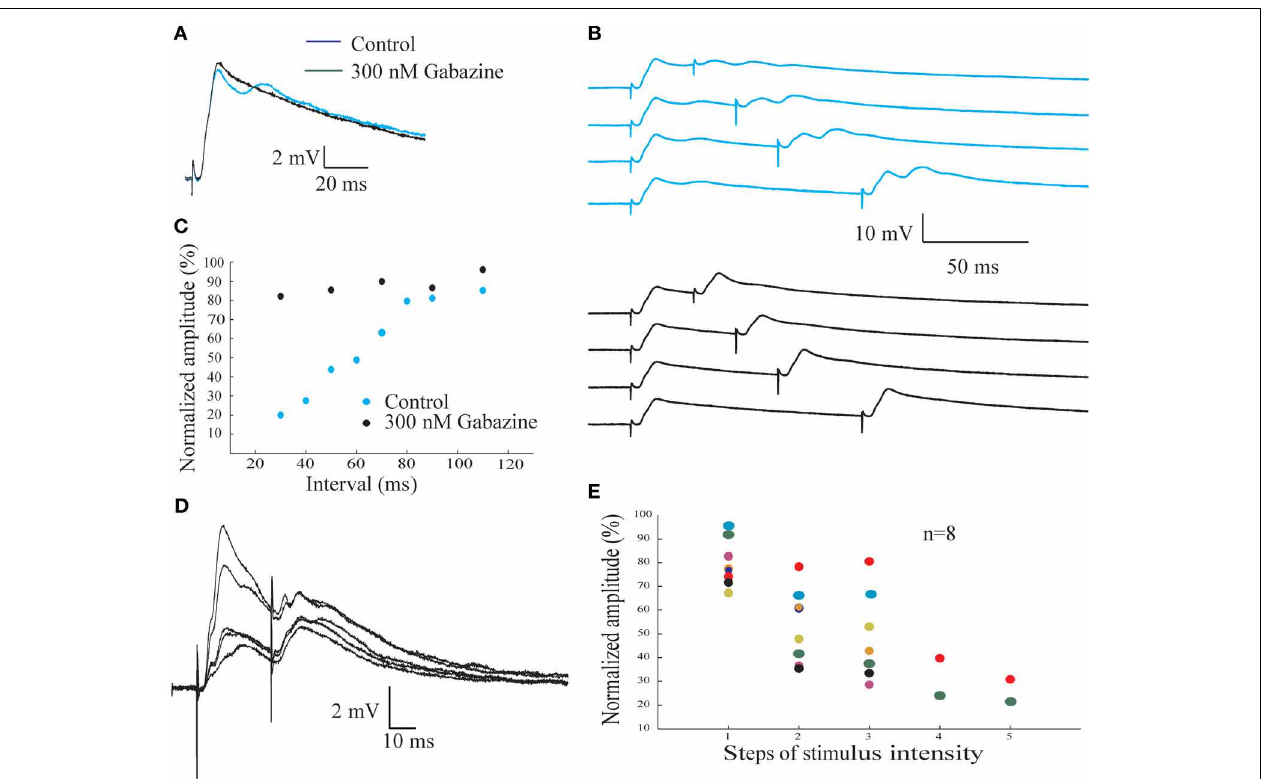
FIGURE 7 | The inhibitory input to the AEN revealed by afferent nerve paired pulse stimulating protocol. (A) Synaptic potentials response evoked by afferent nerve paired pulse stimulation before (blue trace) and after (black trace) gabazine application. (B) Afferent nerve paired pulse stimulation protocol at 30, 50, 70, and 110m intervals before (upper pane l) and after (lower panel) gabazine application. (C) The normalized amplitude of the second synaptic response as a function of the interval between the stimuli